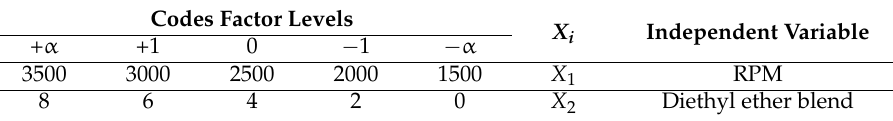
Table 7. Independent variables for central composite design (CCD).